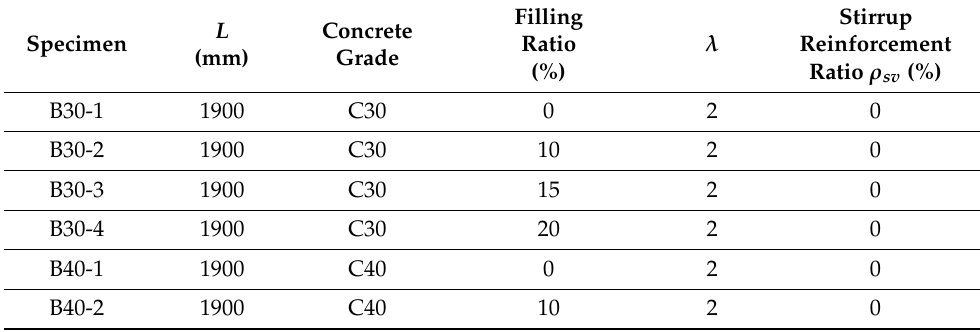
Table 3. Design parameters of beam